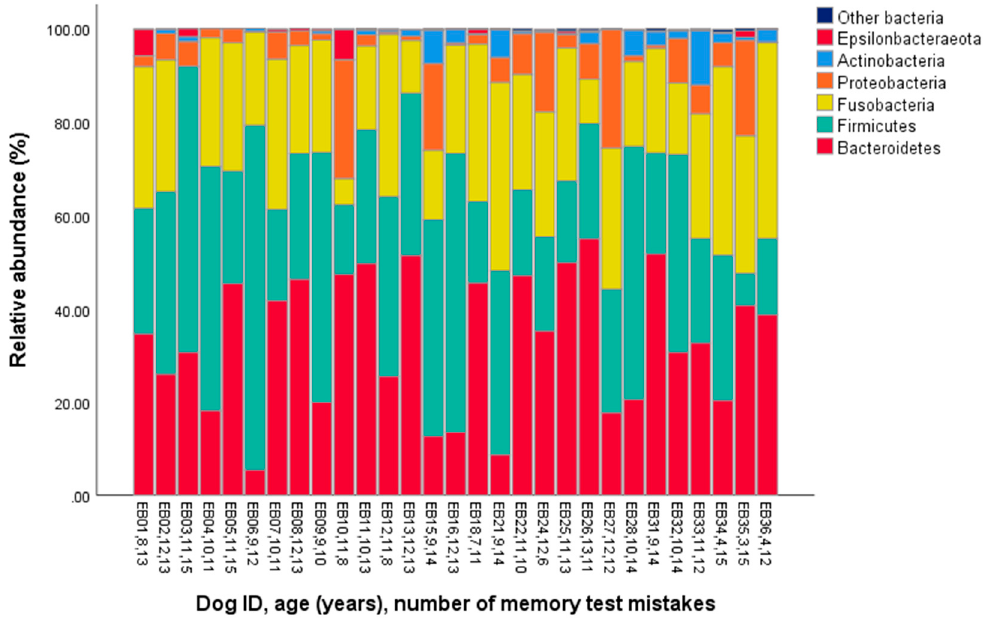
Figure 1. Phylum-level gut microbiota composition in the fecal samples of 29 companion dogs.